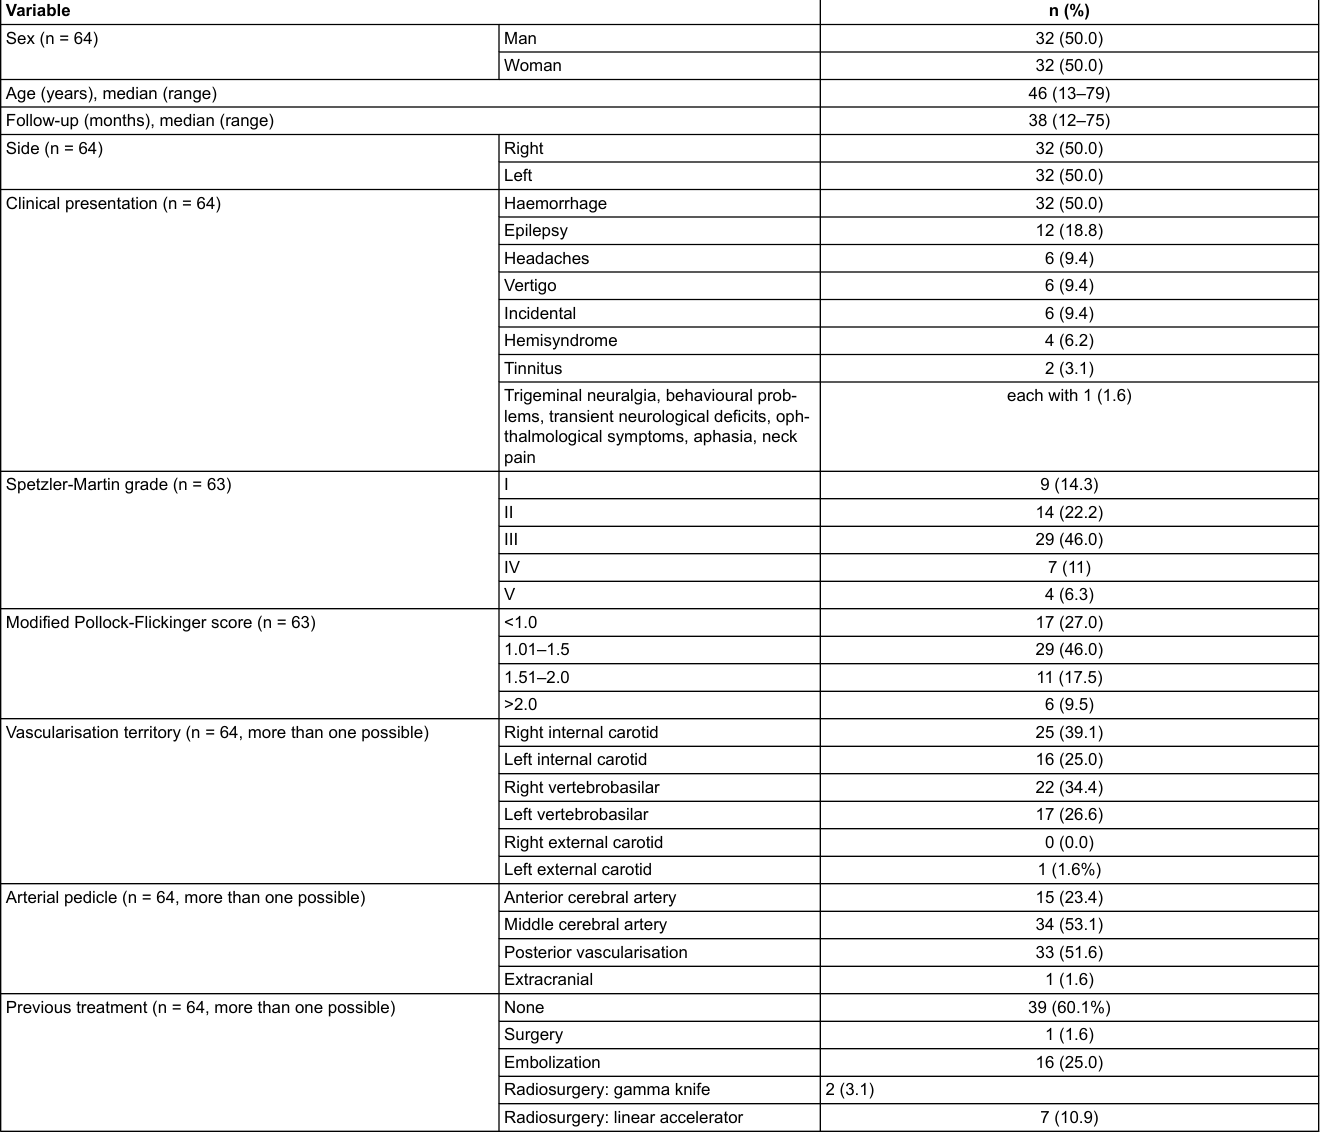
Table 1: Demographic and clinical data before gamma knife radiosurgery